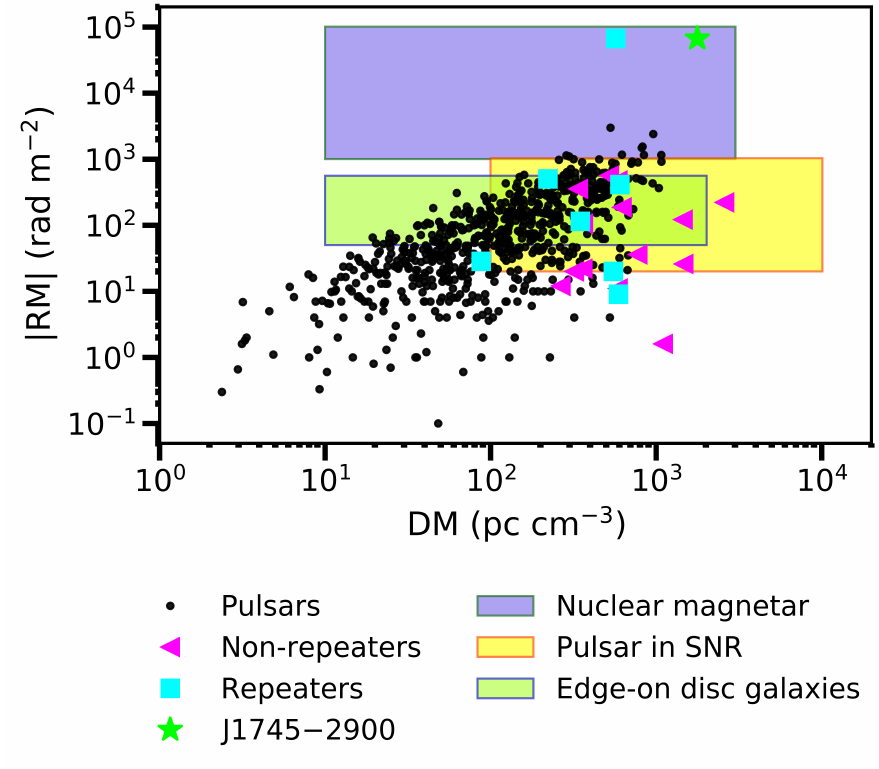
Figure 6. Comparison of the DMs and RMs of pulsars and FRBs. The FRB DMs are upper limits as they are the total observed values. The shaded regions indicate various progenitor models in RM–DM space. The similarity of the RM of FRB 20121102A to that of the Galactic centre magnetar J1745 − 2900 suggests an association with an AGN for the